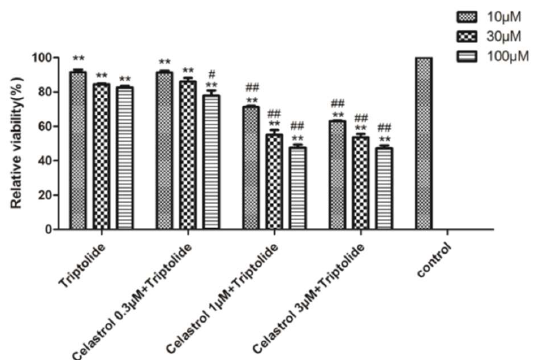
Figure 8. The amount of triptolid in rat primary hepatocyte. ( A ) Accumulation of triptolid in rat primary hepatocyte after treatment with ABT/PB. ( B ) Amount of triptolid in rat primary hepatocyte after exposure to a series of concentrations of celasreol. Compared with triptolid group, ** p < 0.01.